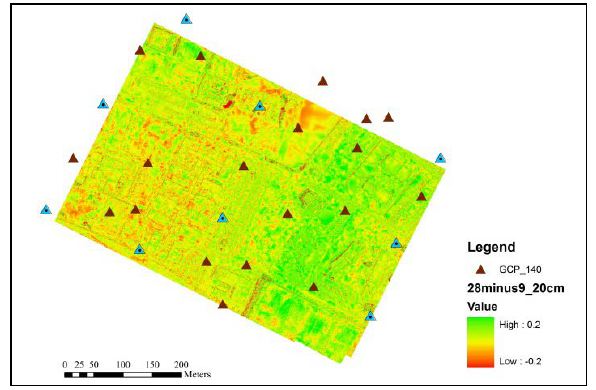
Figure 7 – Raster at 20 cm resolution of the differences between the 140 m flight DSM with 28 GCPs (brown and azure triangles) and 9 GCPs (in azure triangles).